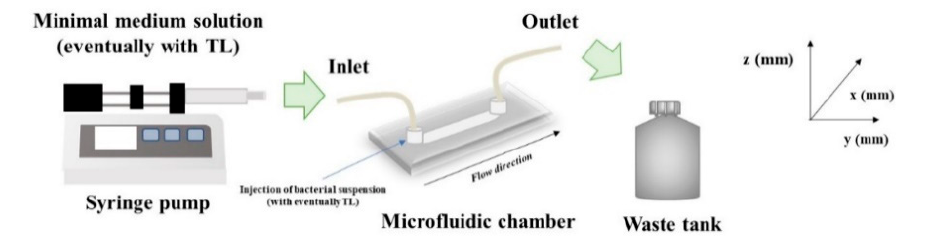
Figure 7. The schematization of the in-flow experimental apparatus.